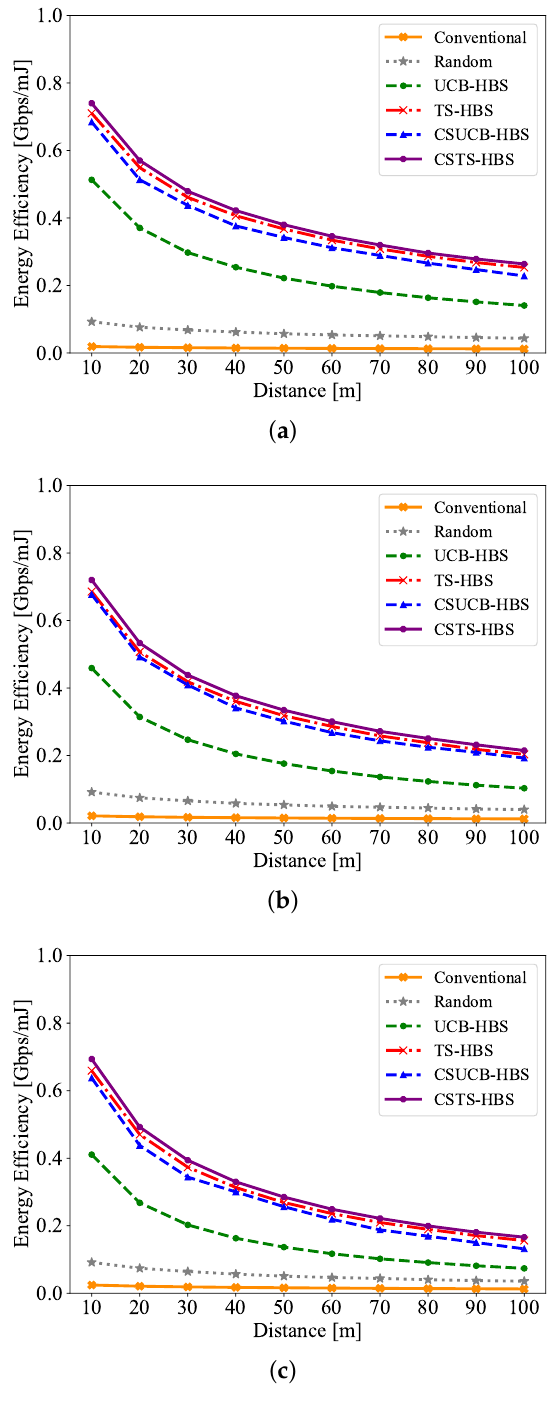
Figure 6. Energy efficiency performance of CSTS/CSUCB-HBS approaches vs. separation distances at distinct blocking layouts. ( a ) No blockage. ( b ) Small blockage. ( c ) Large